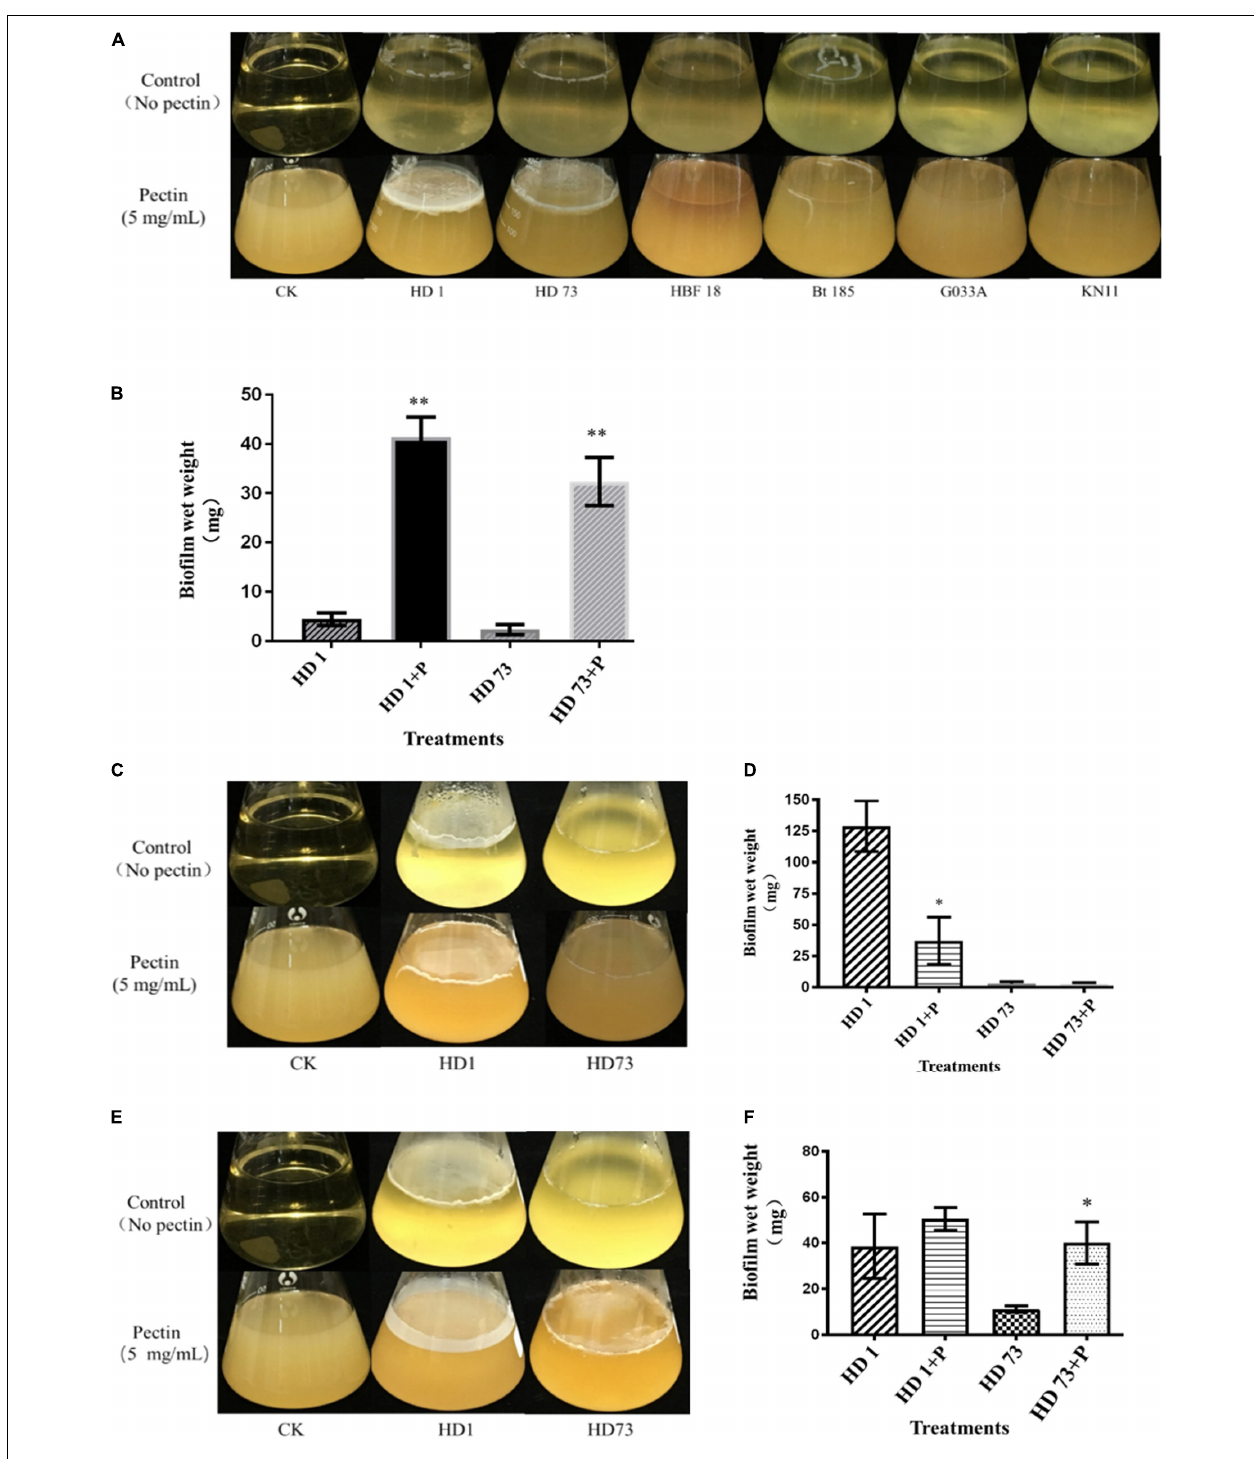
FIGURE 3 | Effects of pectin on the biofilms formed by industrial Bt cellsat the air–liquid interfaces. (A) Bt strains HD1, HD73, Bt185, HBF18, Bt185, G033A, and KN11 that are currently used for industrial production were selected to test the effect of pectin on the biofilm formation of Bt logarithmic growth phase cells. (B) Quantification of the results of Bt HD1 and HD73 from (A) . (C) Bt strains HD1 and HD73 that are currently used for industrial production were selected to test the effect of pectin on the biofilm formation of Bt sporangial phase cells. (D) Quantification of the results of Bt HD1 and HD73 from (C) . (E) Bt strains HD1 and HD73 that are currently used for industrial production were selected to test the effect of pectin on the biofilm formation of Bt lysis phase cells. (F) Quantification of the results of Bt HD1 and HD73 from (E) . P in the figures B–F represents pectin. * and ** represent a significant difference and an extremely significant difference between the biofilms formed by the Bt strains without or with pectin induction,